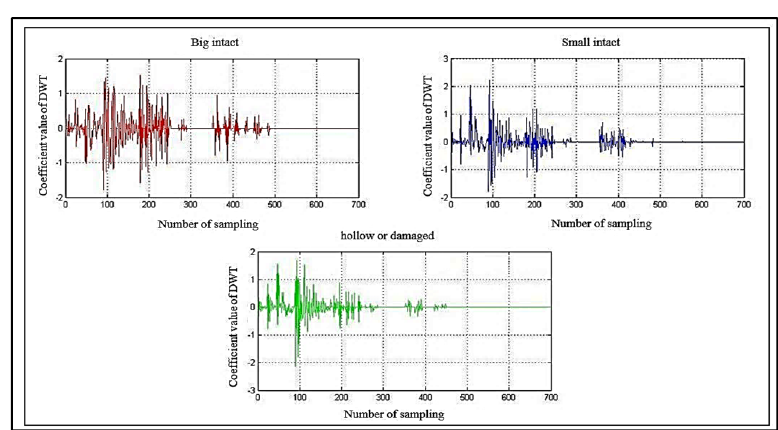
Figure 16. Signal curve of a hazelnut in the wavelet domain.